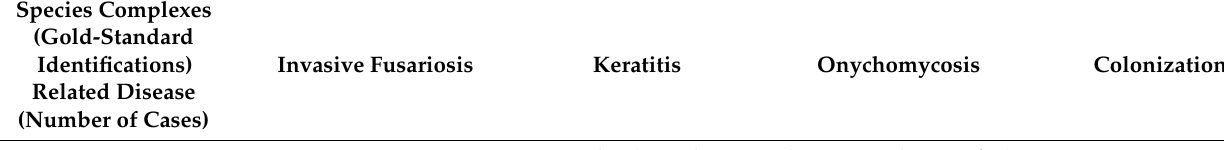
Table 1. Distribution of 160 clinical Fusarium spp. isolates collected in 20 European centers during a one-year prospective study within the different species complexes and species according to the clinical